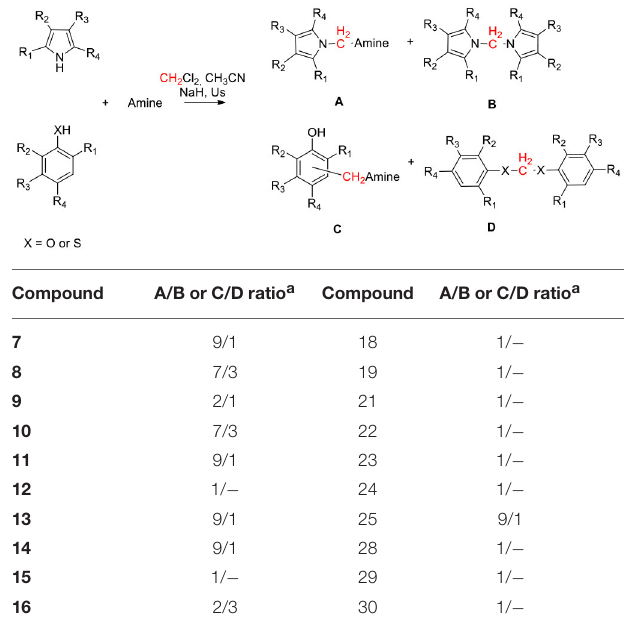
TABLE 3 | Selectivity of the aminomethylation